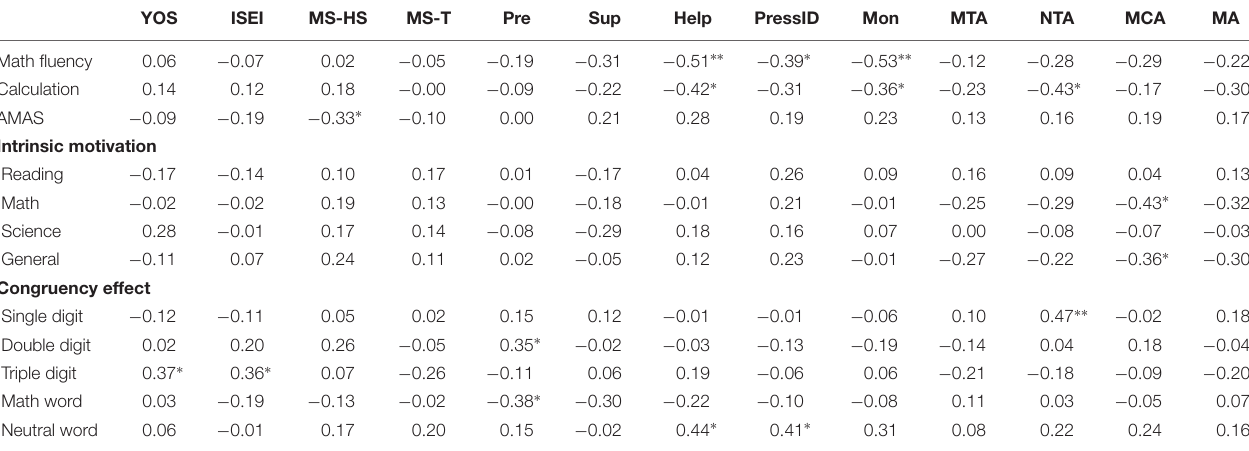
TABLE 3 | Pearson correlation matrix between mothers’ and children’s variables.